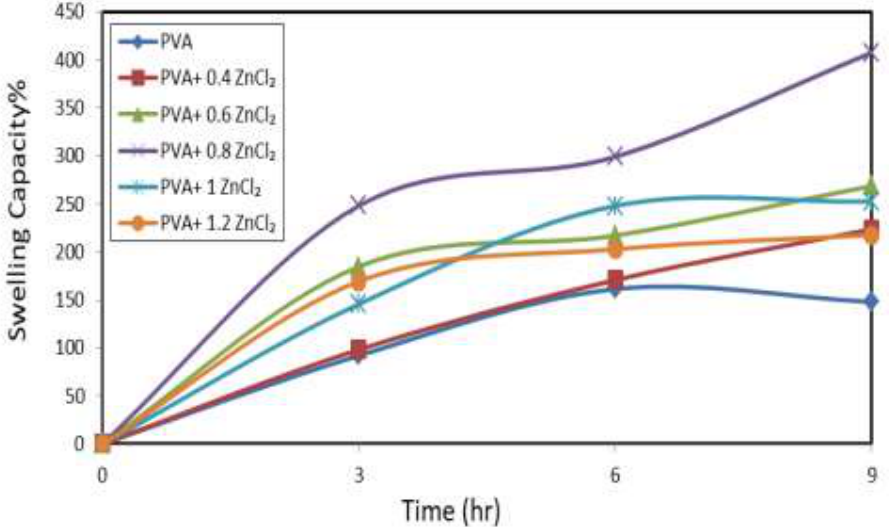
Figure 9 : Swelling Ratio (%) of PVA and (Zn-PVA) SAPs.